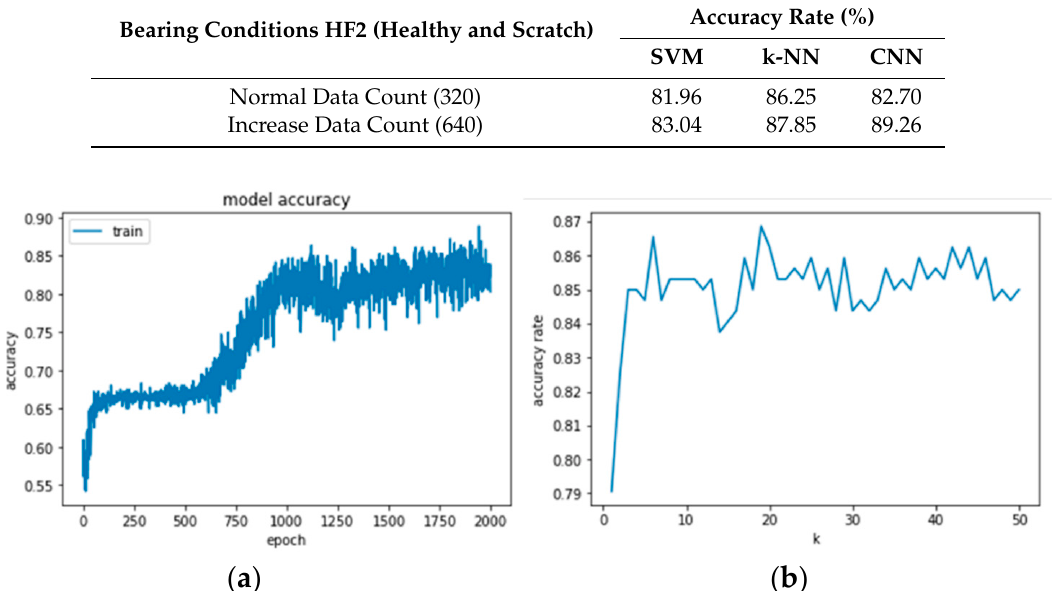
Figure 13. Diagnosis accuracy result of HF2; CNN ( a ) and k-NN ( b ). Table 4. Diagnosis result comparison.